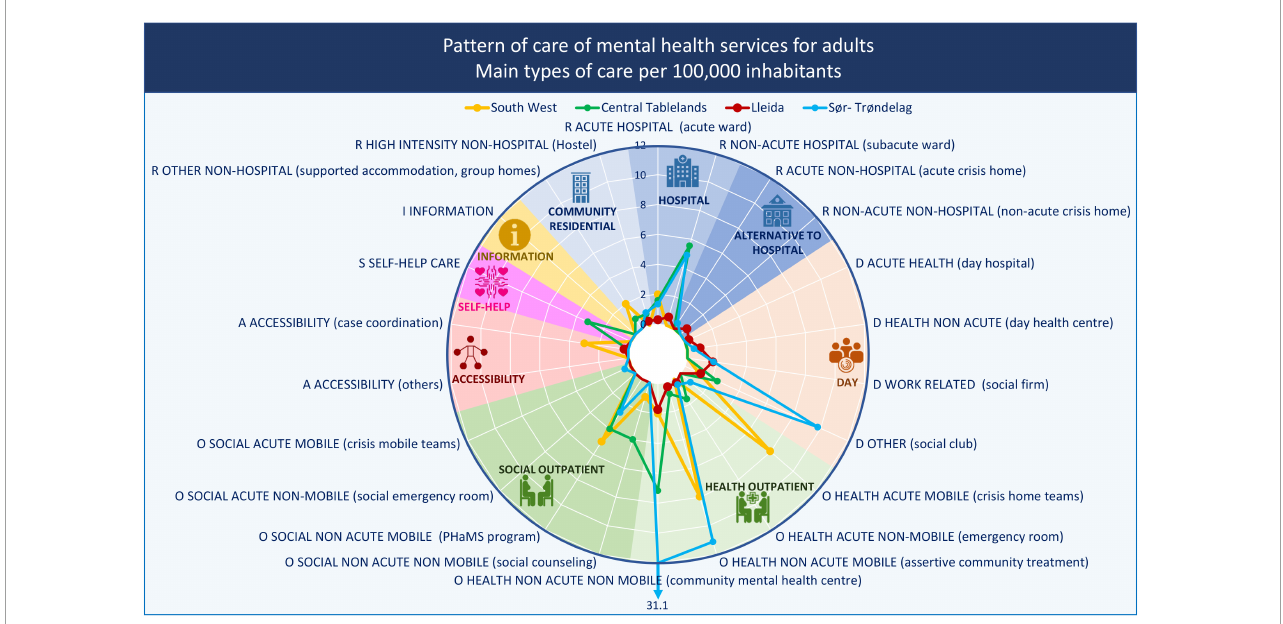
FIGURE2 Adult mental health service provision by main type of care (MTC) group in the South West and Central Tablelands regions (Australia), Lleida (Spain), and Sør-Trøndelag (Norway). R, residential care; D, day care; O, outpatient care; S, self-help care. Rates of groups of care for adults per 100,000 adult